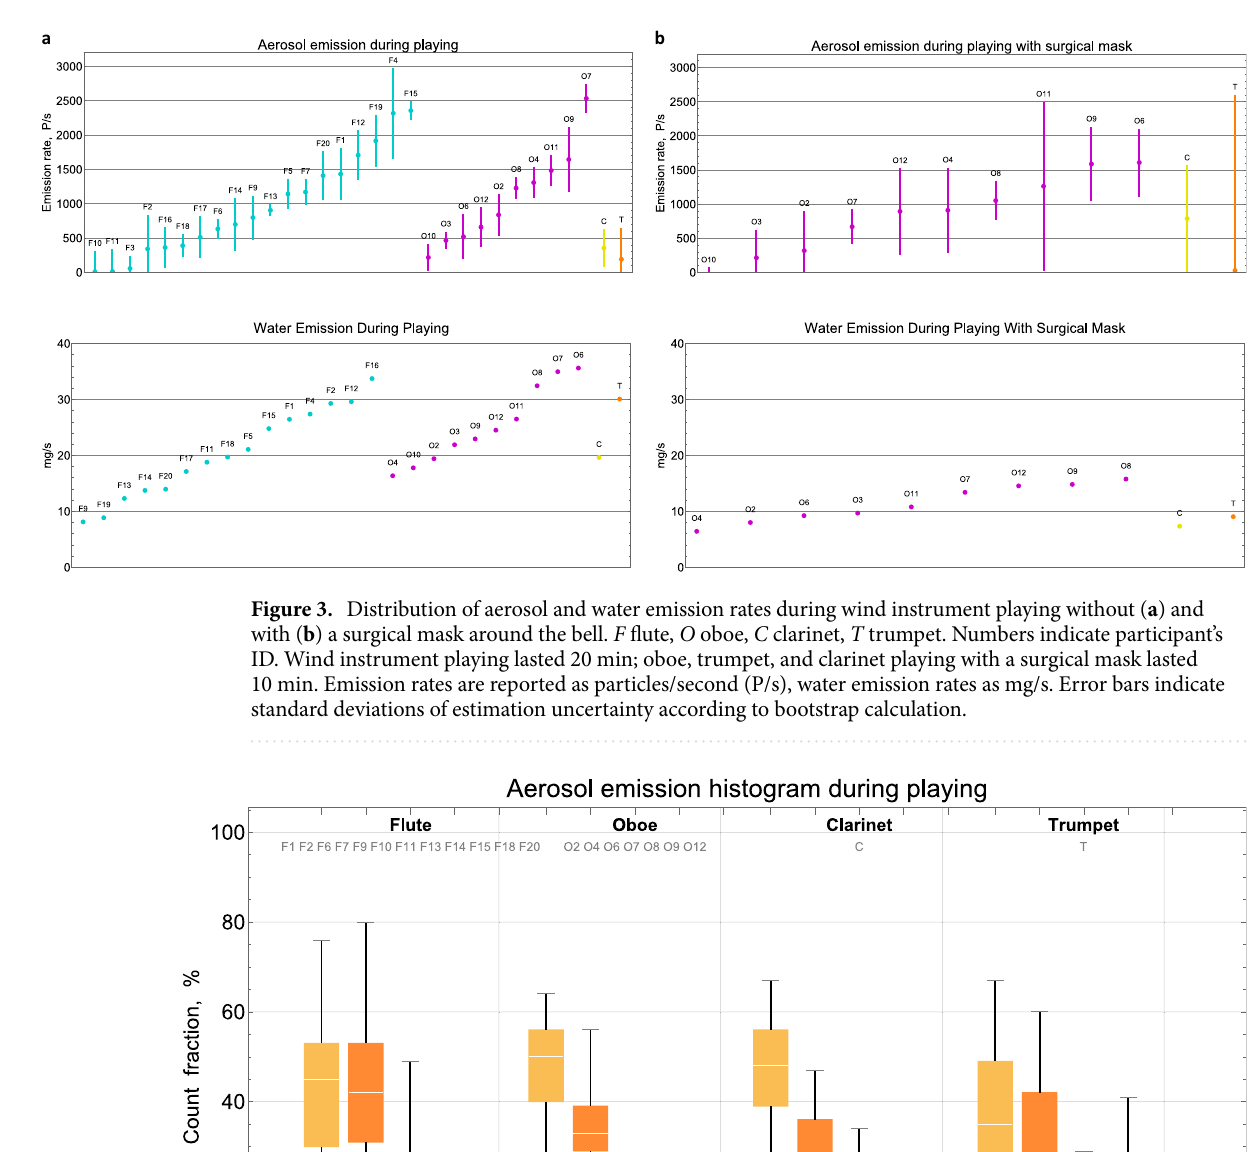
aerosol emission rates from playing with and without mask, U = 64, p = 0.62. Figure 3b shows a uniform distribu- tion of the aerosol emission rates from playing with a surgical mask around the bell D(12) = 0.17, p = 0.84. Figure 6 compares the aerosol emission rates from playing with and without mask. The semiaxes of the ellipses indicate the standard deviations of estimation uncertainty. The individual aerosol emission rates are consistent between both tasks (playing with and without mask) as indicated by the ellipses intersecting the gray line in most cases, except one outlier showing the expected reduction of emission by the mask (oboist no. 7). Water emission. Complementary to the total aerosol emission rates, we calculated the total water emission rates from the continuous increase of relative humidity during task performance. The water emission rates show a uniform distribution, flute D(15) = 0.15, p = 0.83, oboe D(10) = 0.30, p = 0.27, like the aerosol emission rates (see